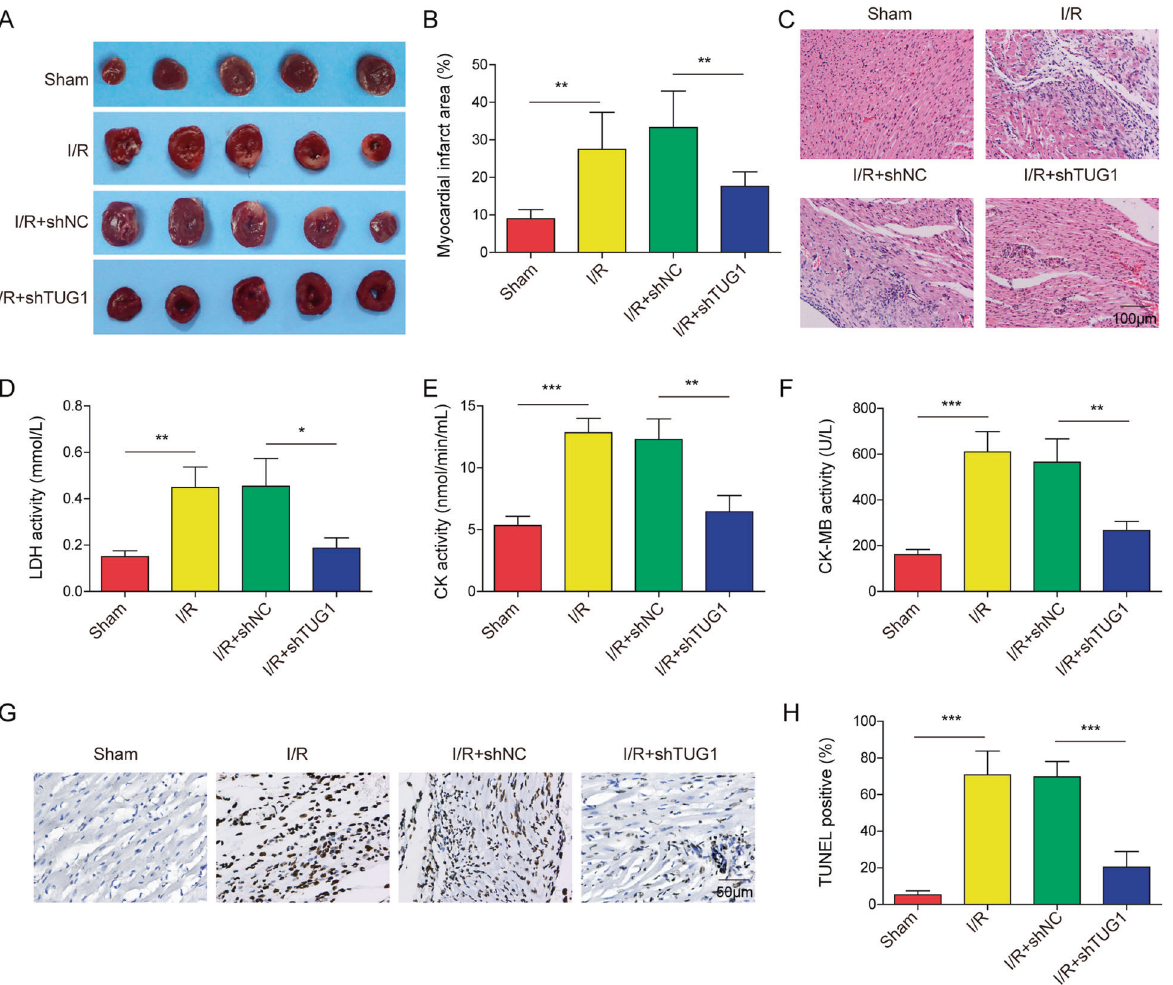
Fig. 7 Silencing TUG1 reduced I/R-induced myocardial damage in a mouse model. A , B TTC staining was used to show the region of MI in the myocardial tissue of I/R mice. C Histological changes in the myocardial tissue were examined using H&E staining. The serum levels of D LDH, E CK, and F CK-MB were determined using ELISA. G , H Cell death was determined using TUNEL staining. * P < 0.05, ** P < 0.01 and *** P <